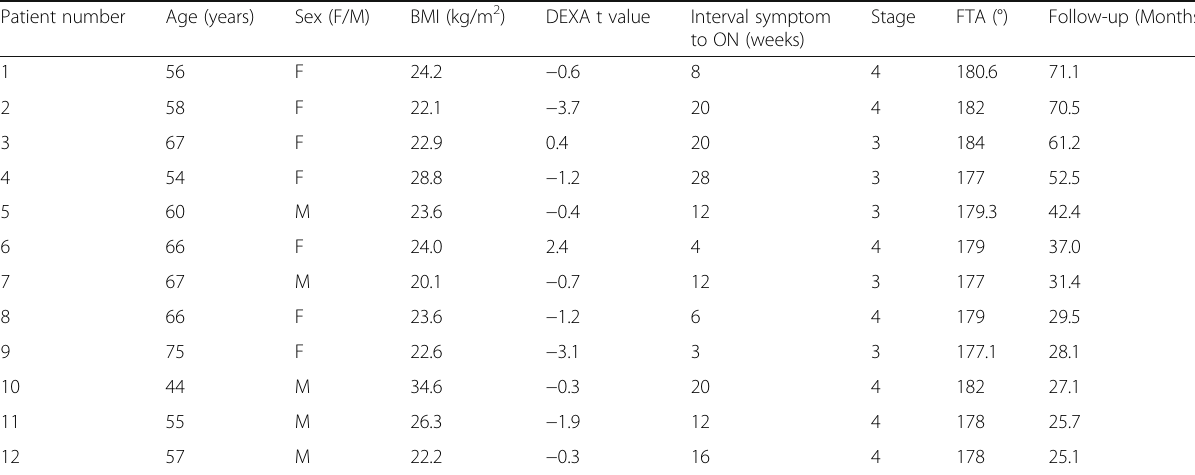
Table 2 Clinical data of the patients Patient